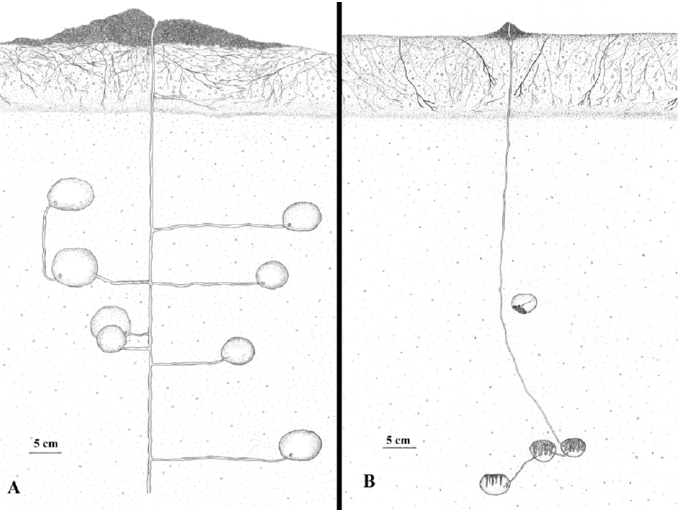
Figure 5. Two nest architectures found in Mycocepurus nests. ( A ) A Mycocepurus goeldii nest; ( B ) A Mycocepurus smithii nest.